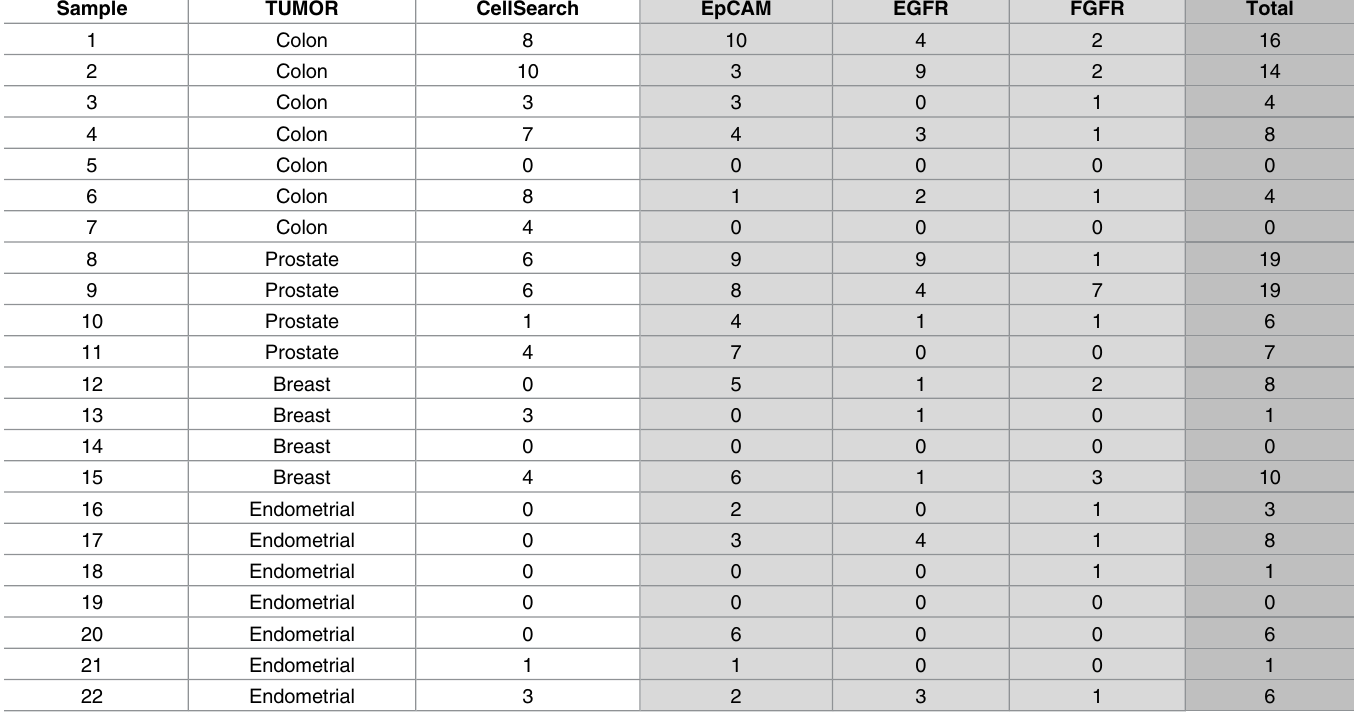
Table 3. Comparison of CTCs isolated by CellSearch or magnetic beads coated with anti-EpCAM, anti-EGFR or anti-FGFR from patients with metastatic cancer. Total refers to the sum of the three